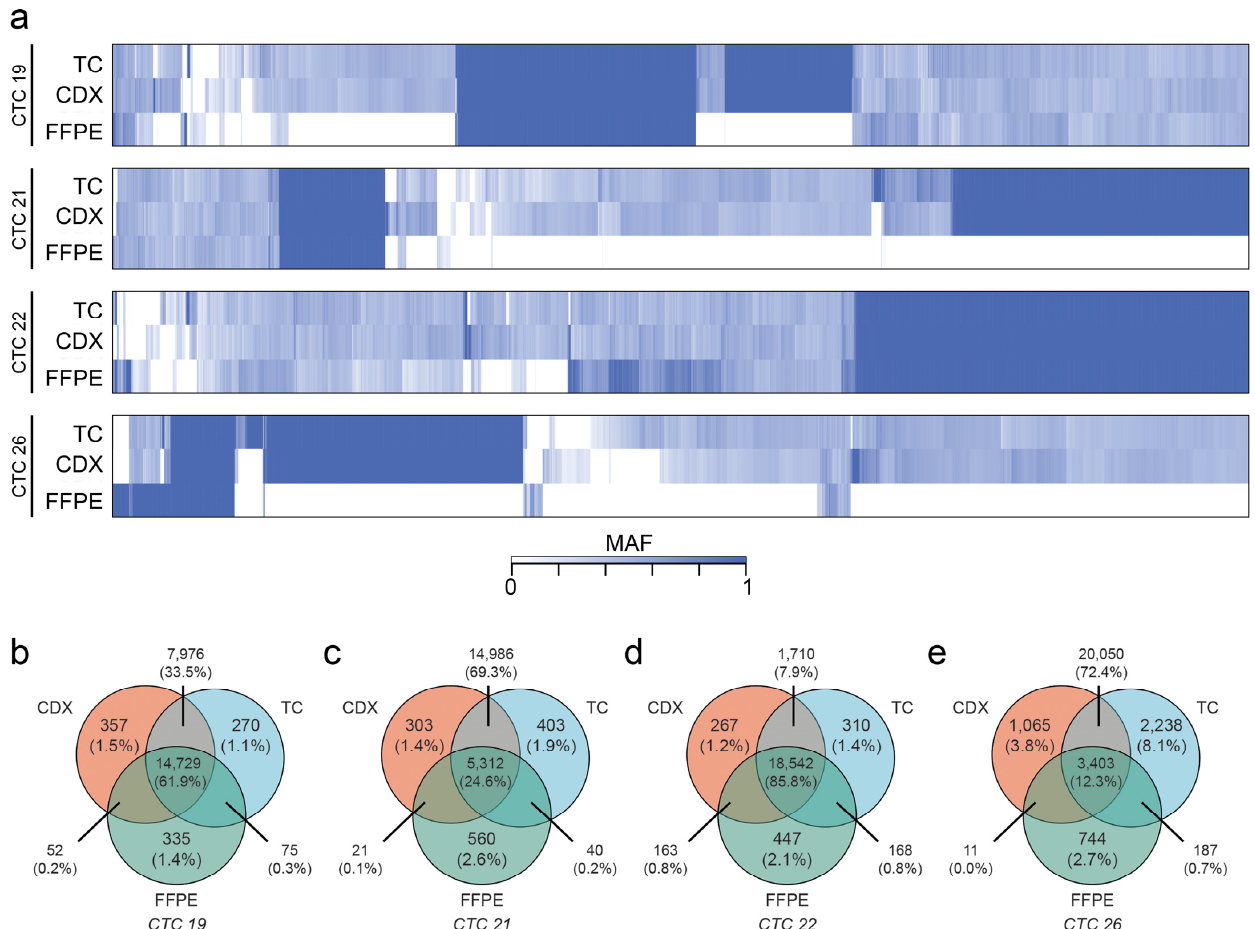
Figure 6. Whole-exome sequencing revealed concordance and discordance between the patient’s tumor and corresponding CTC models (TC and CDX). ( a ) Heat maps depicting the mutant allele fraction (MAF) of all mapped mutations across patient-matched CTC cultures (“TC”), CDX primary tumors (“Tumor”), and clinical formalin-fixed paraffin embedded (“FFPE”) tissue. More mutations were recovered from CTC and CDX tissues than FFPE, on average. An MAF indicates homozygous mutation, while 0.5 indicates heterozygous mutation. ( b – e ) Mutations were then mapped in a Venn diagram to determine the number of overlapping and sample-exclusive mutations for each patient.